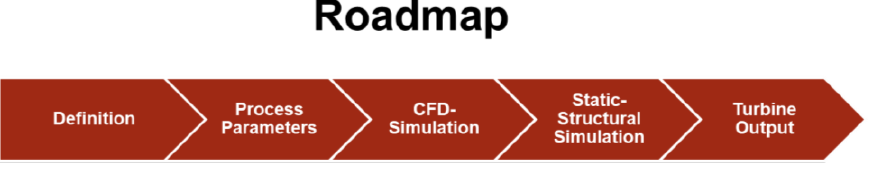
Figure 8. Conception of the simulation model involving the rotor geometry and volume of water.